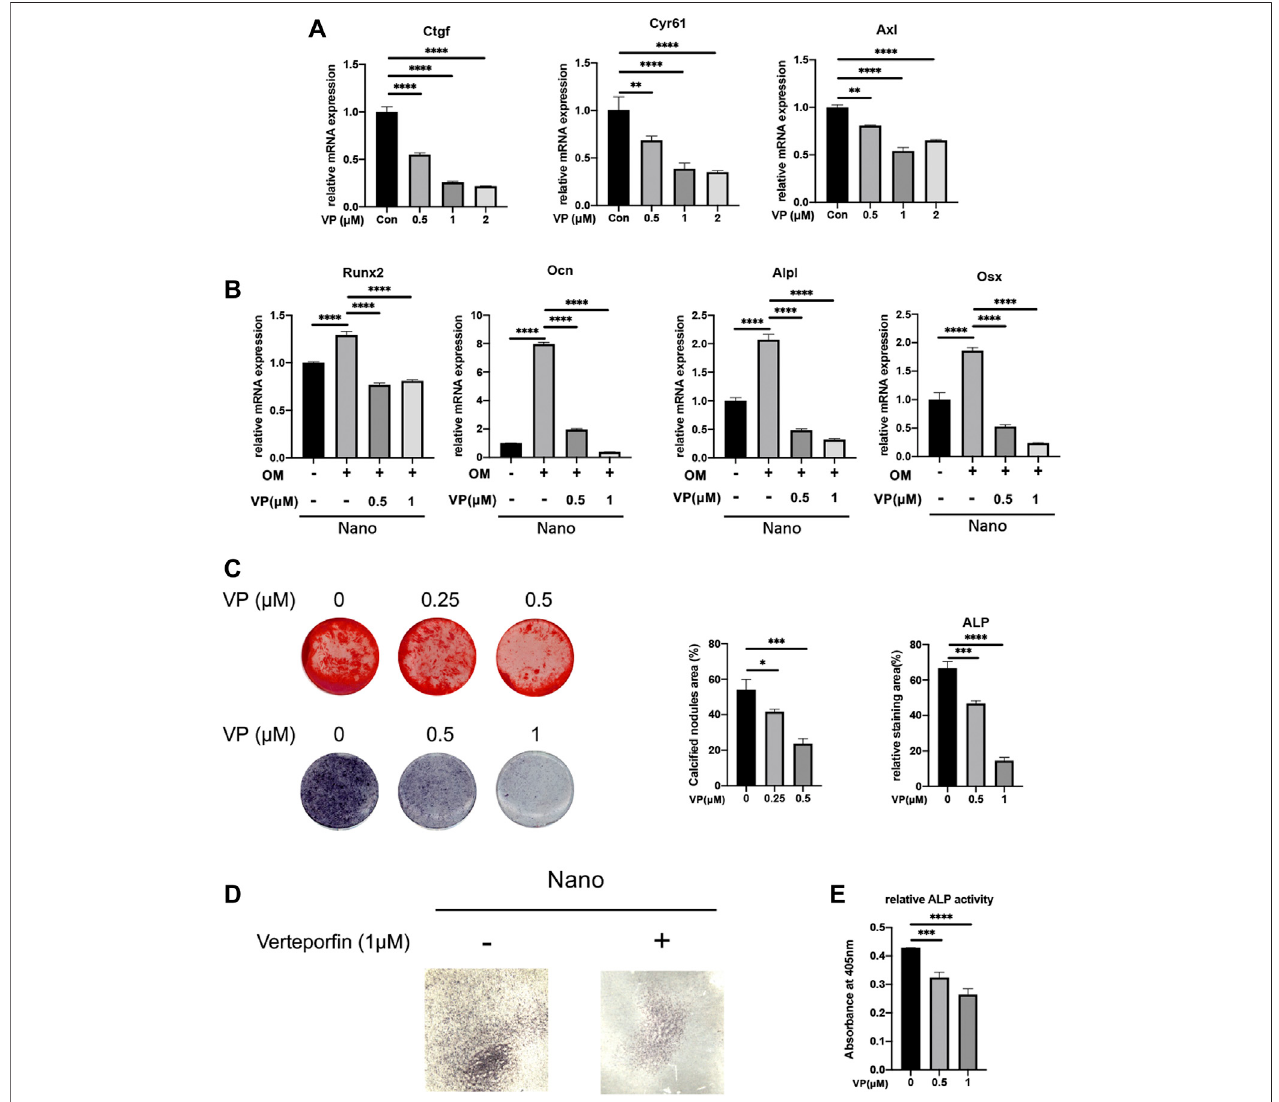
FIGURE 4 | Yap inhibitor, vertepor fi n, inhibits osteogenic differentiation of MC3T3-E1 cells seeded on nanotubes or 24-well plates. (A) Gene expression of Yap downstreamgenesCtgf,Cyr61,andAxlunderdifferentconcentrationsofvertepor fi n. (B) ExpressionofosteogenicgenesofMC3T3-E1cellsseededonnanotubes.OM: osteogenic induction medium. (C) Alizarin Red S staining and ALP staining of MC3T3-E1 cells seeded on 24-well plates and quantitative analysis of calci fi ed nodules areas and relative ALP staining areas. (D) ALP staining of MC3T3-E1 cells seeded on nanotubes with vertepor fi n. (E) Relative ALP activities of MC3T3-E1 cells on nanotubes treated with vertepor fi n. * p < 0.05, ** p < 0.01, *** p < 0.001, and **** p <